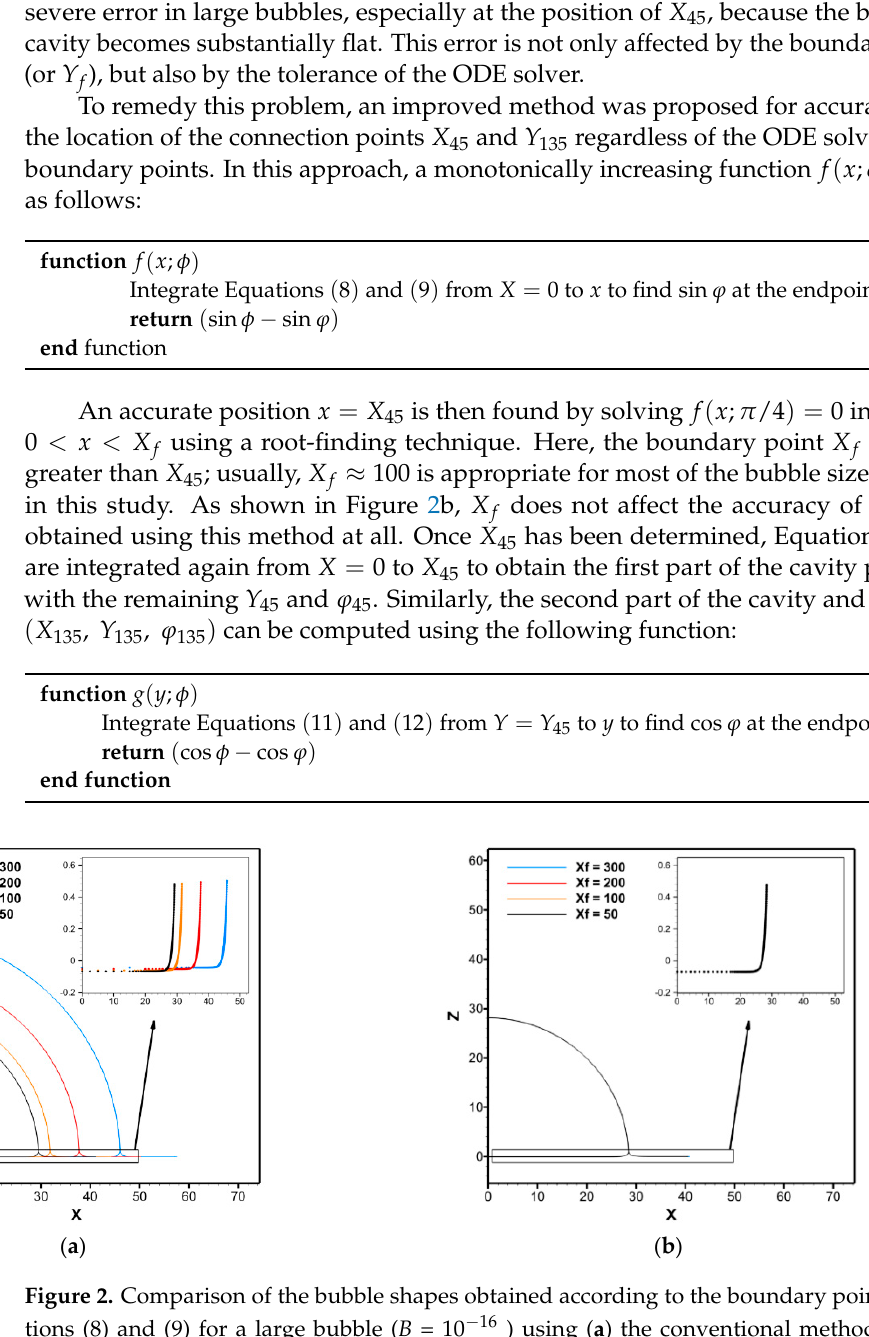
( b ) Figure 3. Comparison of the bubble shapes obtained according to the tolerance of the ODE solver for a large bubble ( B = 10 (cid:2879)(cid:2869)(cid:2874) ) using ( a ) the conventional method, and ( b ) the improved method involving the root-finding technique. The insets plot the cavity profiles up to 45 degrees and are not scaled. 3.2. Finding the Junction Point Based on the Type of Meniscus There are two general approaches to finding the junction point 𝑐 according to the direction of integration of the meniscus. The first approach is to integrate the meniscus from 𝑋 = 𝑋 (cid:2998) to 𝑋 (cid:3030) in the negative X -direction [29,31]. Here, 𝑋 (cid:2998) is sought in an iterative manner so that the derivatives of the meniscus and cavity profiles match at the junction point 𝑐 . However, it is difficult to compute the shape of the meniscus using this method